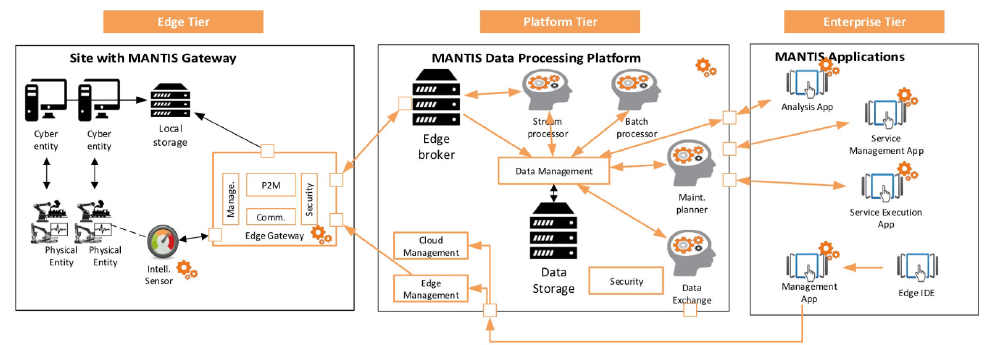
Figure 7. Overview of the MANTIS reference architecture